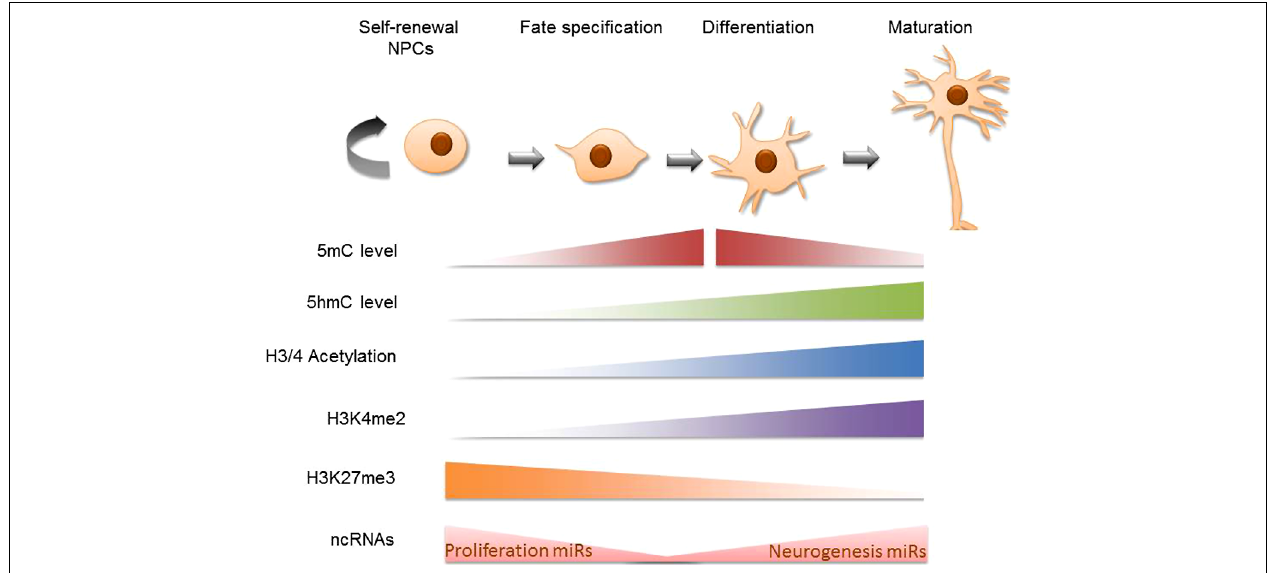
mature cells such as those in the mouse cortical plate are richer for these markers than the neural progenitor cells that preceed them (Cho etal., 2011). H3K4me2 is primarily acquired in the neural progenitor cell stage and becomes pronounced in the matured brain cell stage (Zhang etal., 2012). H3K27me3 has been shown to be negatively correlated with 5 hmC on intergenic regions during NPC differentiation (Hahn etal., 2013). Finally, MicroRNAs that support proliferative gene expression are diminished as self-renewable NPCs become specified neural precursors while pro-neurogenesis non coding RNA are upregulated during NSC conversion to a mature neuronal state (Meza-Sosa etal.,